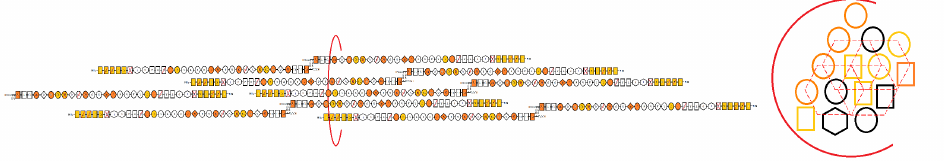
Figure 3. Assembly of FN fibrils. FN assembly is facilitated by interactions between domains I 1–5 (yellow rectangles) and several Type III domains (various circles). FN is in an extended conformation in FN fibrils, and as such, most likely enables multiple FN–FN binding events within the cross section of the fibril. Since stretched III domains can bind via β -strand addition, it is possible that fibril maturation and insolubility is driven by these binding events. Computational models of FN fibrillogenesis have assumed a hexagonal packing organization [7,25], but actual molecular organization is not known. A cross section on the left demonstrates how different domains within the FN moelcule may interact with a range of domains from neighboring FN molecules within the